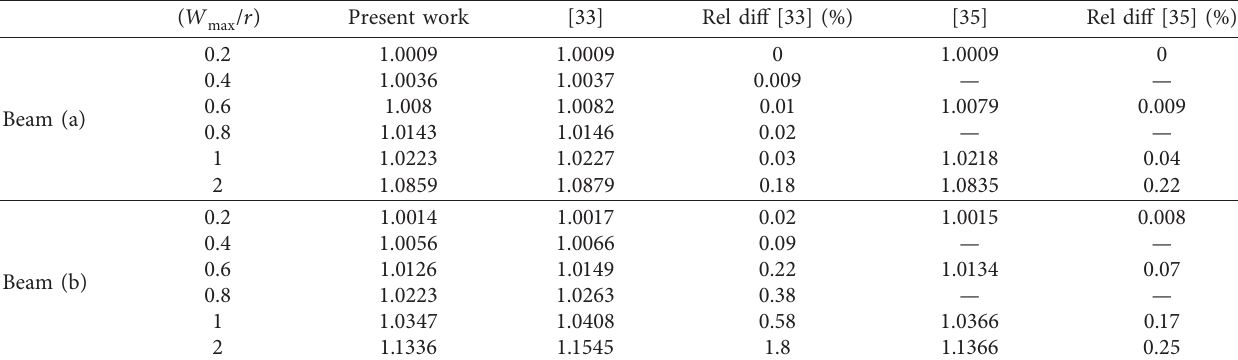
Table 9: ( ω ) for clamped-tapered beams in which beam (a) is varying in breadth and beam (b) is varying in depth, with a taper ratio ����� NL / ω ( I / S ) α � 0 . 4 and r �